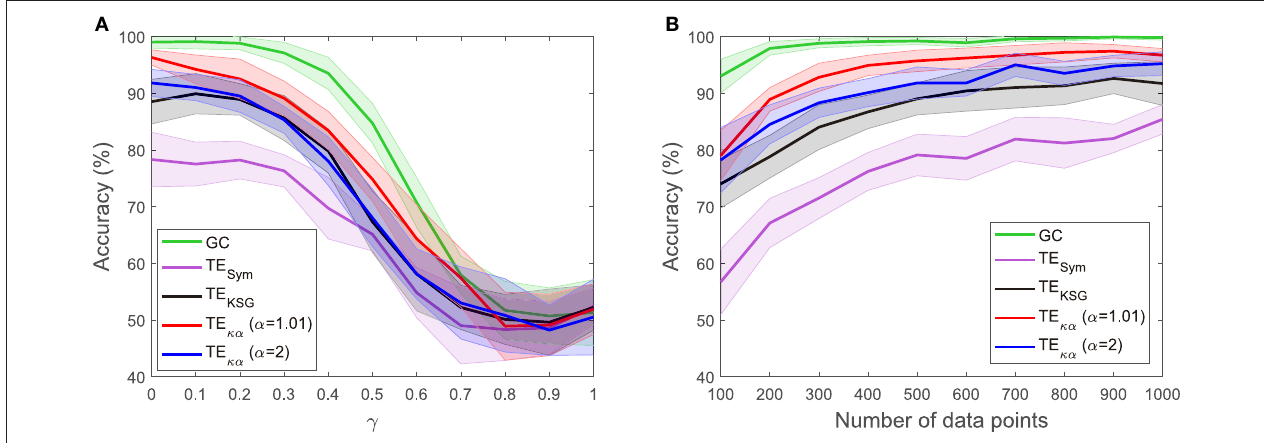
FIGURE 2 | Accuracies in the detection of the preferred direction of information flow for synthetic data generated from a unidirectional bivariate autoregressive model of order 3: (A) for varying symmetric noise levels (as a function of the parameter γ ), (B) for a varying number of data points.